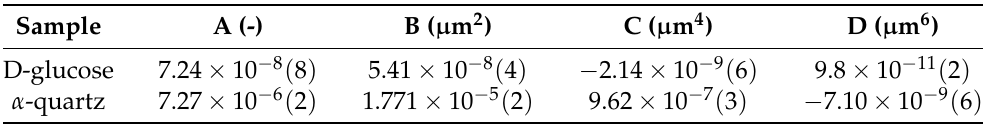
Table 2. Cauchy parameters for κ -fits for D-glucose and α -quartz. Values in parenthesis are the confidence limits in the last decimal.